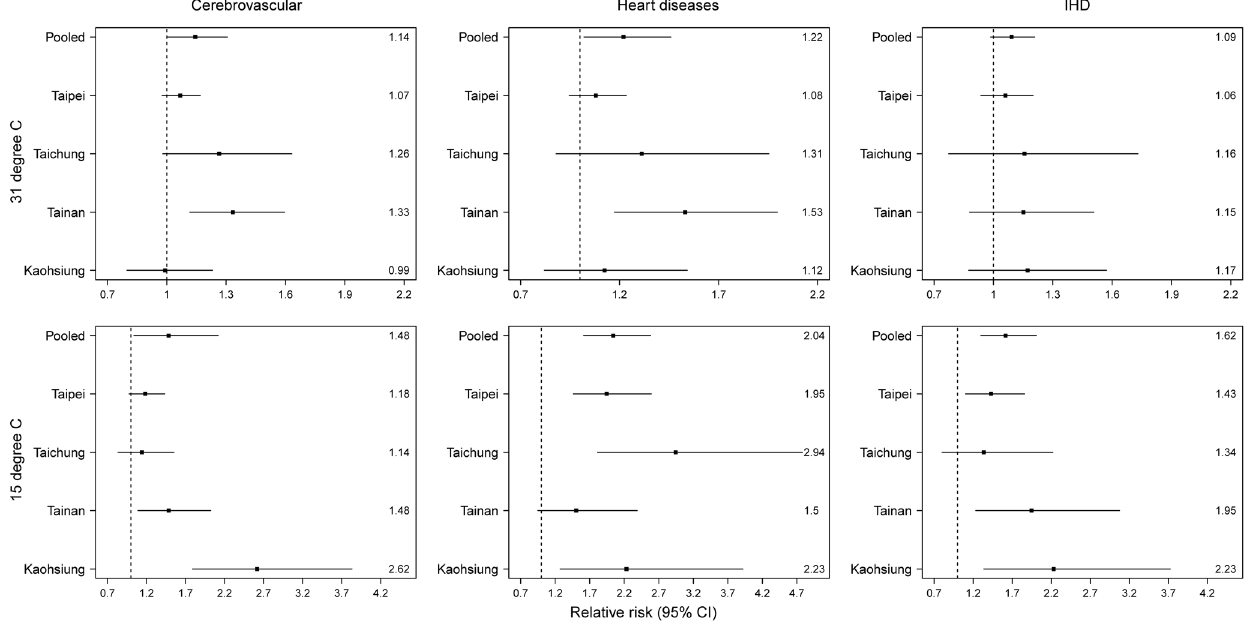
Figure 6. Metropolitan-specific and pooled relative risk estimates for the cumulative 21 days at 15 u C and cumulative 4 days at 31 6 C compared to a centered temperature of 27 6 C using DLNM, controlling for the consecutive days of temperature extremes, daily city-specific averages of PM 10 , NOx, O 3 , and RH, daily mortality from pneumonia and influenza, holiday effects, day of a week, and long-term trends. Pooled risk estimates were obtained by random-effect meta-analysis.